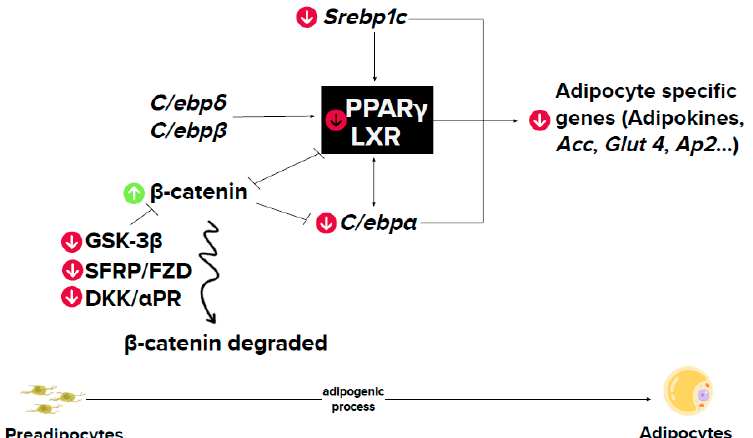
Figure 3. Mechanism of action underlying the effect of isorhamnetin on adipogenesis. α PR: proges- terone receptor α ; ACC: acetyl coA carboxylase; AP2: adipose fatty acid-binding protein 2; C/ebp: CCAAT-enhancer-binding protein; DKK: Dickkopf; FZD: frizzled class receptor; GLUT4: glucose transporter member 4; GSK-3 β : glycogen synthase kinase-3 beta; PPAR γ : peroxisome proliferator activated receptor γ ; RXR α : retinoid X receptor alpha; SFRP: secreted frizzled related protein; SREBP1c: sterol regulatory element-binding protein 1c. Green arrows: upregulation by isorhamnetin; red arrows: downregulation by isorhamnetin.